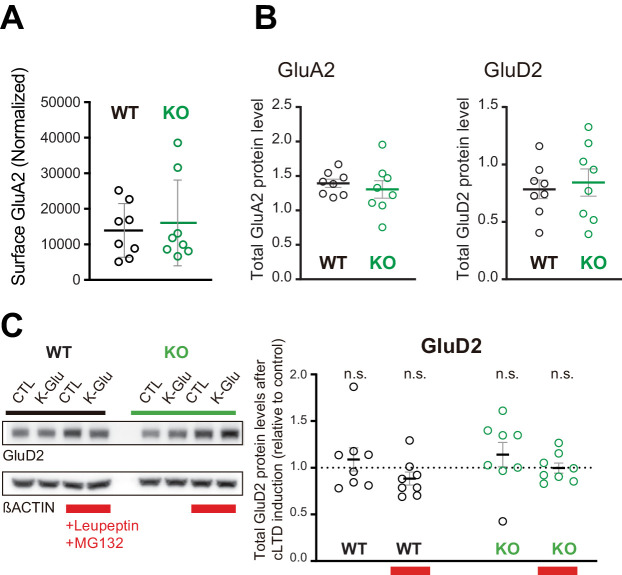
Basal surface GluA2 levels and total GluA2 and GluD2 levels in SUSD4 knockout (KO) mice.(A) Surface GluA2 levels (relative to normalized GluA2 input) in basal conditions were not different on average in acute cerebellar slices from Susd4 KO when compared to slices from wild-type (WT) mice. (B) and (C) Total protein levels (normalized to βACTIN) of GluA2 (B) and GluD2 (C) were not changed in acute cerebellar slices from Susd4 WT or KO mice in basal conditions. Mean ± s.e.m. (n = 8 independent experiments; unpaired Student’s t-test; GluA2: p=0.5424; GluD2: p=0.6821). (D) Cerebellar acute slices from control WT and Susd4 KO mice were incubated to induce chemical LTD (cLTD; K-Glu: K+50 mM and glutamate 10 μM for 5 min followed by 30 min of recovery). Slices were incubated with 100 µg/mL leupeptin and with 50 µM MG132 (to inhibit lysosomal and proteasome degradation, respectively). Band intensities of GluD2 were normalized to βACTIN. The ratios between levels with cLTD induction (K-Glu) and without cLTD induction (CTL) are represented. Mean ± s.e.m. (n = 8 independent experiments; two-tailed Student’s one sample t-test was performed on the ratios with a null hypothesis of 1, PWT = 0.4973, PWT+Leu/MG132 = 0.1433, PKO = 0.3143, PKO+Leu/MG132 = 0.9538, n.s. = not significant).